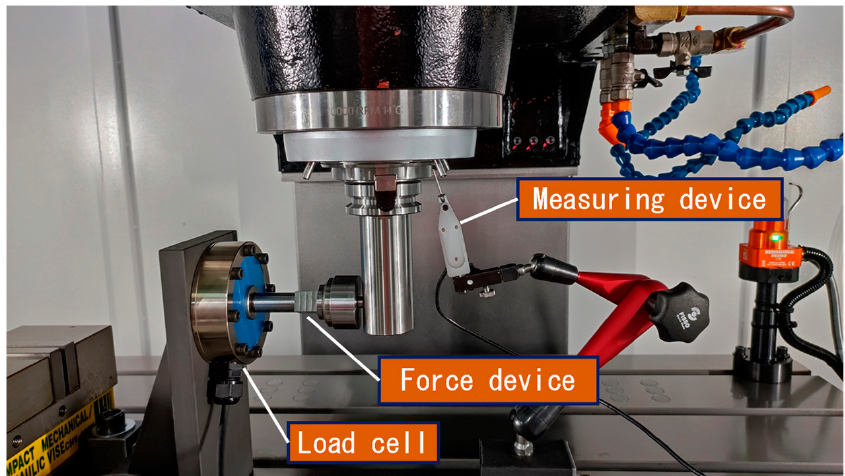
Figure 15. X -axis rigidity test.